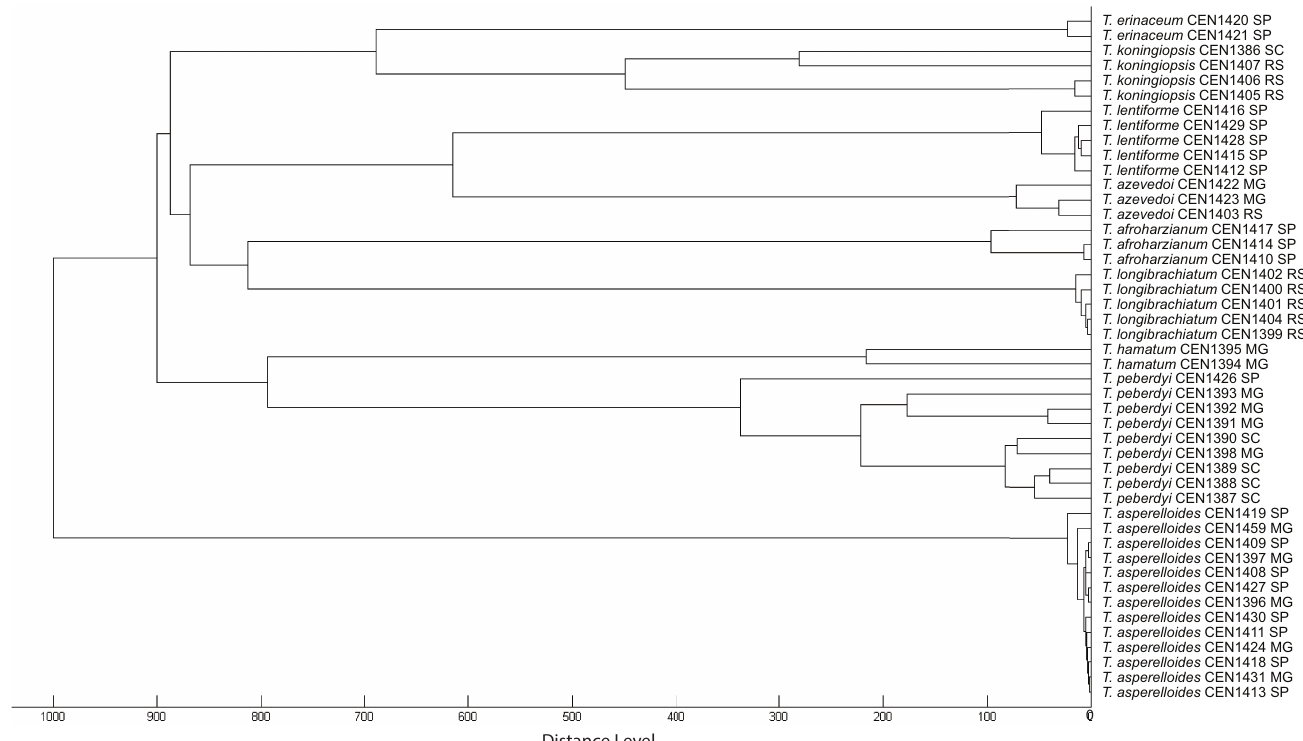
Fig 6. Dendrogram based on MALDI TOF analysis of Trichoderma strains isolated from garlic and onion crop soils. Species names are followed by strain number and collection location by Brazilian state.